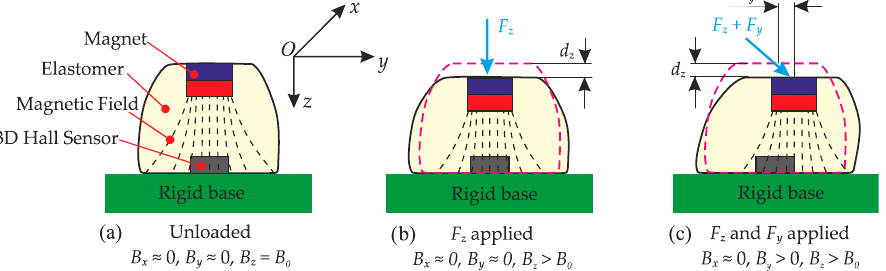
Figure 1. The concept of magnetic field-based three-axis soft tactile sensor: ( a ) Schematic of the tactile sensor (unloaded); ( b ) Tactile sensor ( F z applied); ( c ) Tactile sensor ( F z and F y